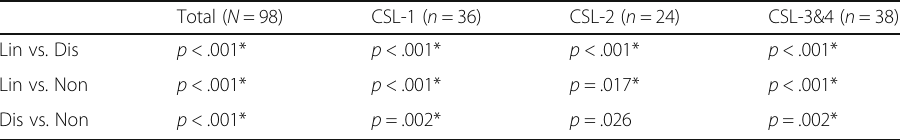
Table 7 Effects of implicature type on comprehension accuracy Total ( N = 98) CSL-1 ( n =